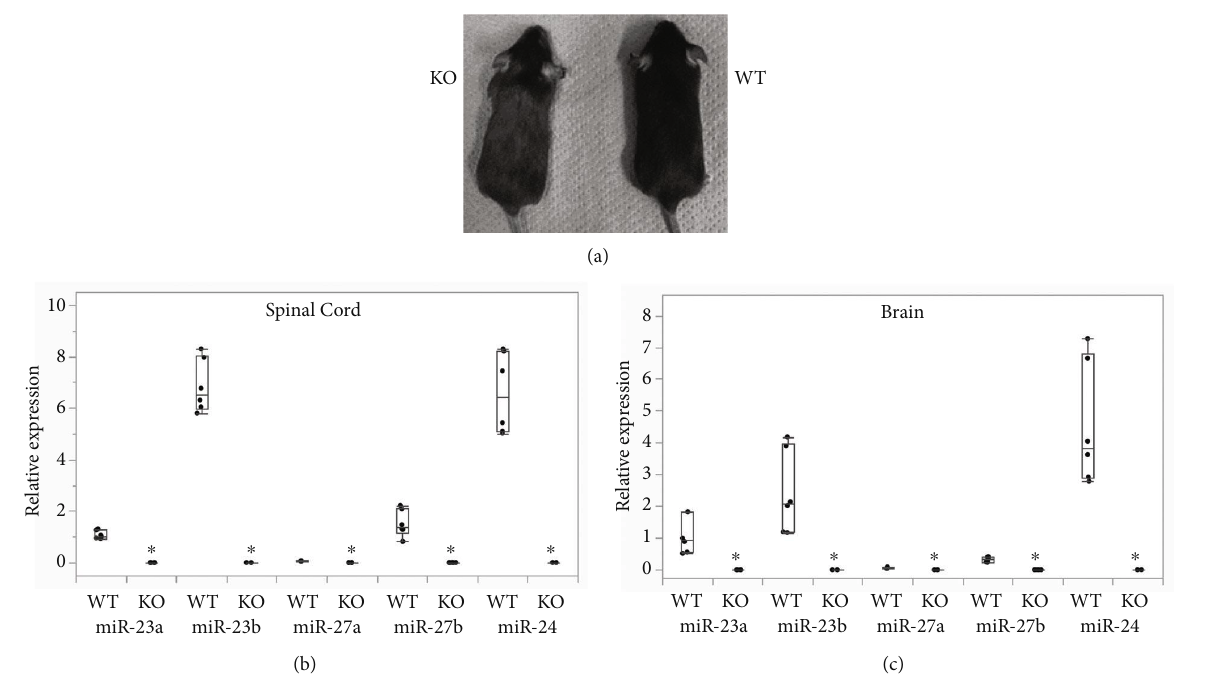
Figure 1: Characteristics of the miR-23-27-24 cluster knockout mice. Wild-type (WT) and miR-23-27-24 cluster knockout (KO). (a) Appearance of the 10-week-old WT and KO mice. (b) Expression levels of the miR-23-27-24 cluster miRNAs in the spinal cord of 10- week-old WT and KO mice, n = 4 per genotype. (c) Expression levels of the miR-23-27-24 cluster miRNAs in the brain of 10-week-old WT and KO mice, n = 4 per genotype. In the KO mice, the expression of all miRNAs was signi fi cantly lower in both the spinal cord and brain. ∗ Signi fi cant di ff erence compared to wild-type mice, p < 0 : 05 . Table 1: Expression of miR-23-27-24 cluster in the central nervous system. Spinal cord